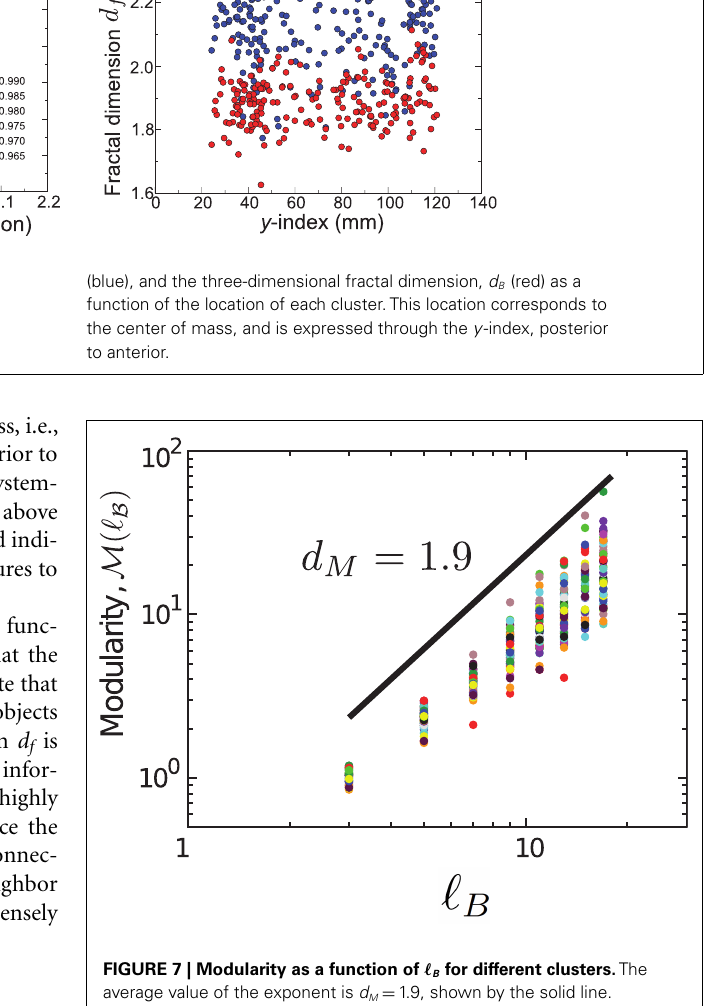
FIGURE 7 | Modularity as a function of (cid:2) B for different clusters. The average value of the exponent is d M = 1.9, shown by the solid